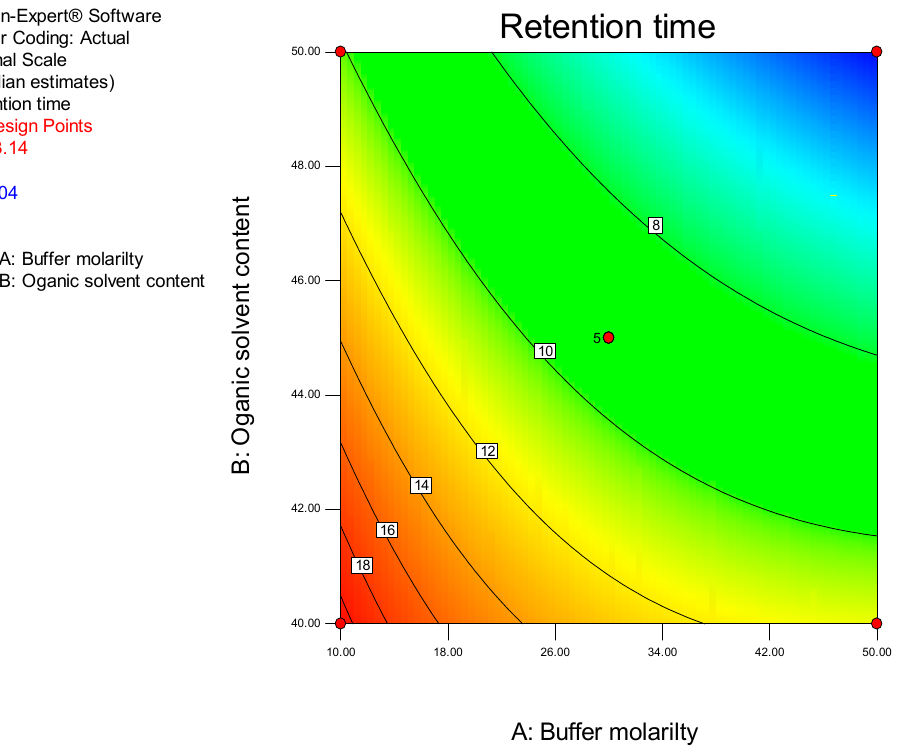
Figure 3. Contour plot depicting the impact of ACN content and buffer molarity on retention time. Examination of the model Box-Cox plot (Figure 4) inferred the need to transform the model. The plot reveals that the blue line fell outside the 95% confidence interval, indicating that the model was